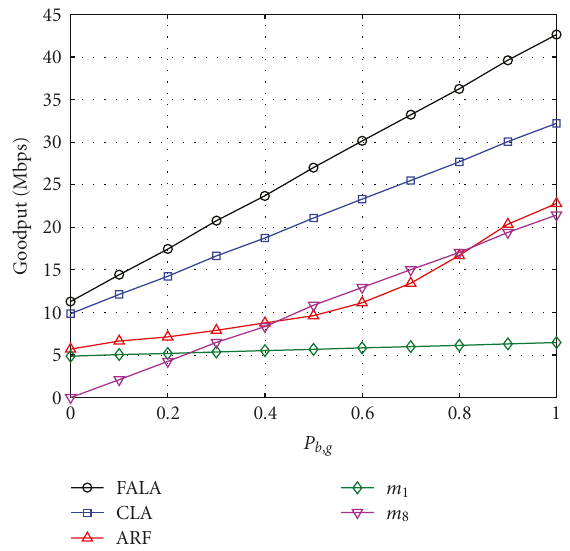
Figure 11: Performance comparison: average goodput versus channel variations with P b , g from 0 to